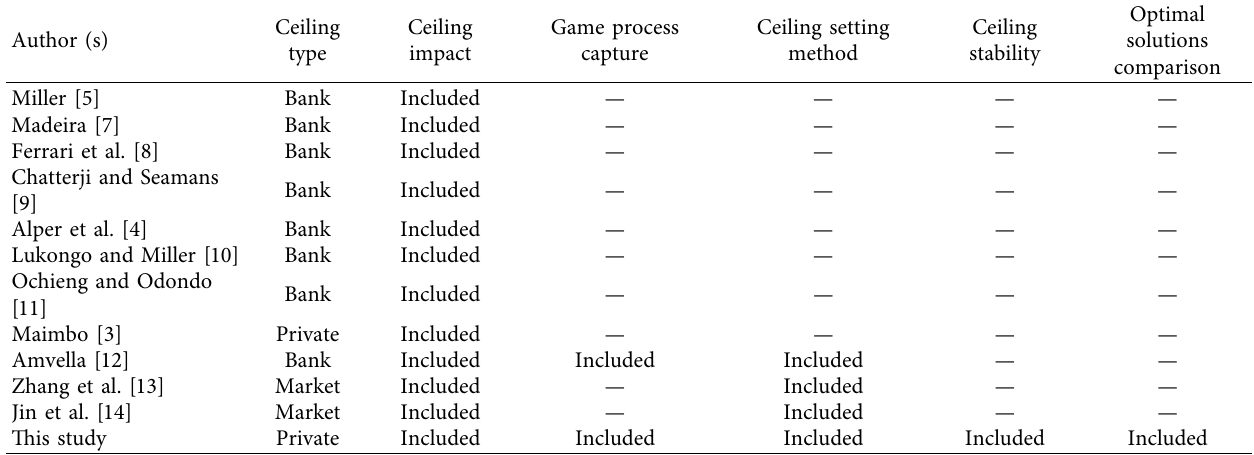
Table 1: A summary of lending rate ceiling’s study contribution.